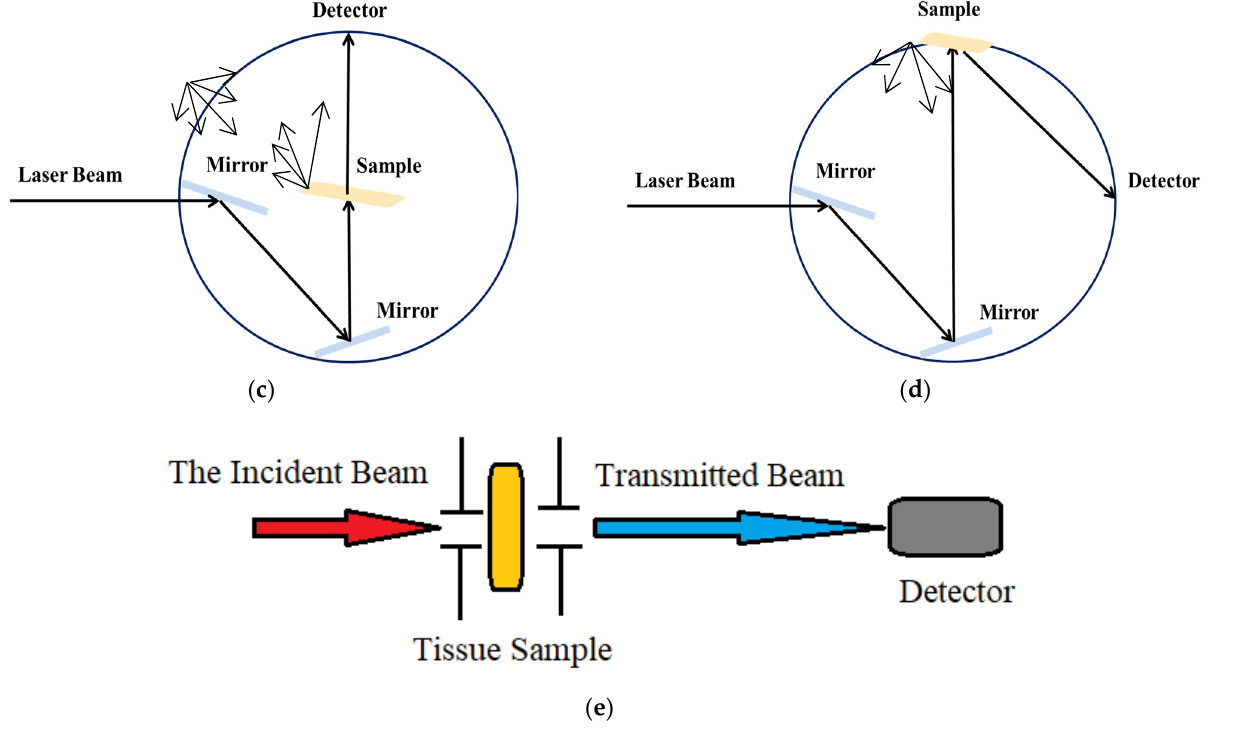
Figure 2. Integrating sphere-based optical configurations for the total transmittance T t ( a ) and diffuse reflectance R d ( b ) measurements; schematics of the total transmittance; ( c ) and diffuse reflectance ( d ) modes and ( e ) collimated transmittance.